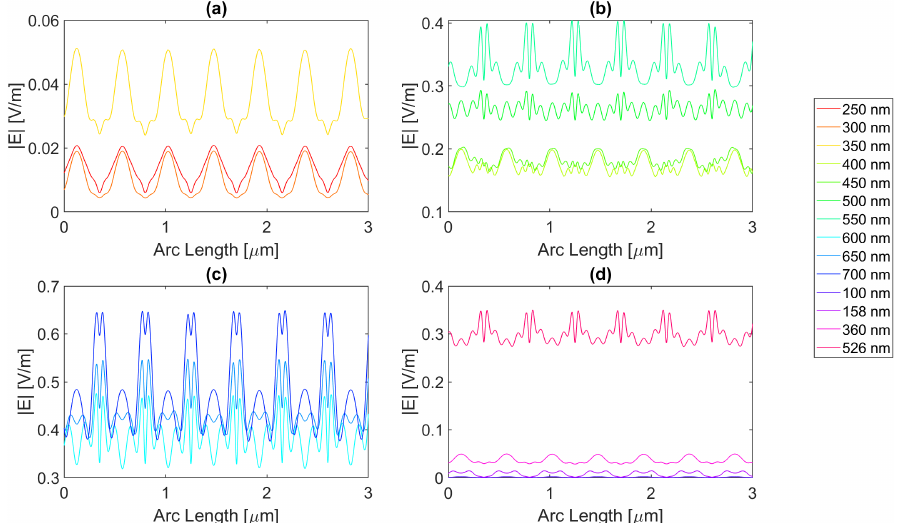
Figure 15. Electric field for the copper circular nanostructure with a 100 nm radius—Probe 1.